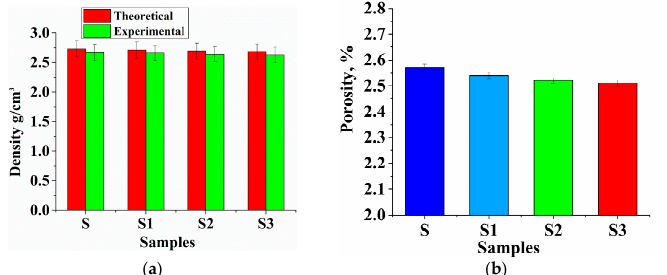
Figure 3. ( a ) Theoretical vs. experimental density of the samples; ( b ) sample’s porosity in